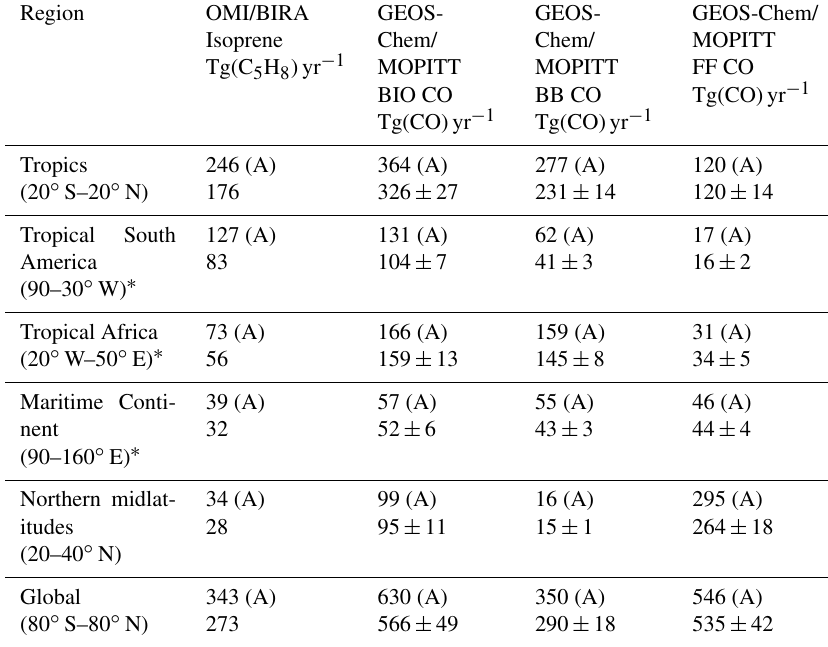
Table 2. Annual average isoprene and sector partitioned carbon monoxide fluxes for 2005–2012.